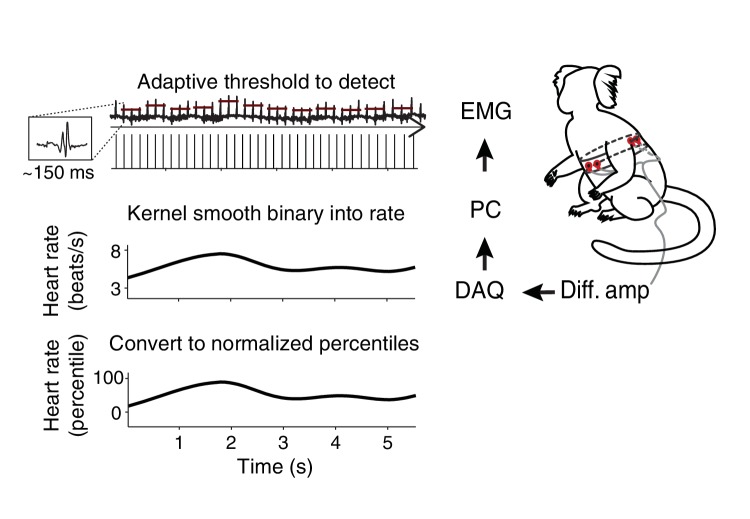
Measurement of arousal state.Illustration showing how heart rate signal was measured from electrocardiographic (ECG) signal. Surface electrodes were applied to the dorsal and ventral thorax of infant marmosets. Signals were process through a differential amplifier (Diff. amp) before being sent to the data acquisition (DAQ) system and the personal computer (PC). The cardiac signal output was isolated (exemplar shown), filtered, and an adaptive threshold was used to detect spikes exceeding the 95% percentile of the signal. Spikes are converted in a binary signal and smoothed with a 1 s Gaussian kernel to extract ongoing heart rate.